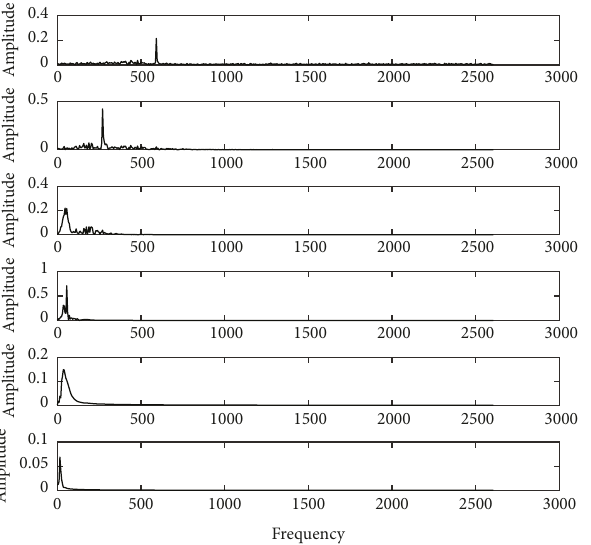
Figure 12: Outlier detection results by EMD for simulated data.